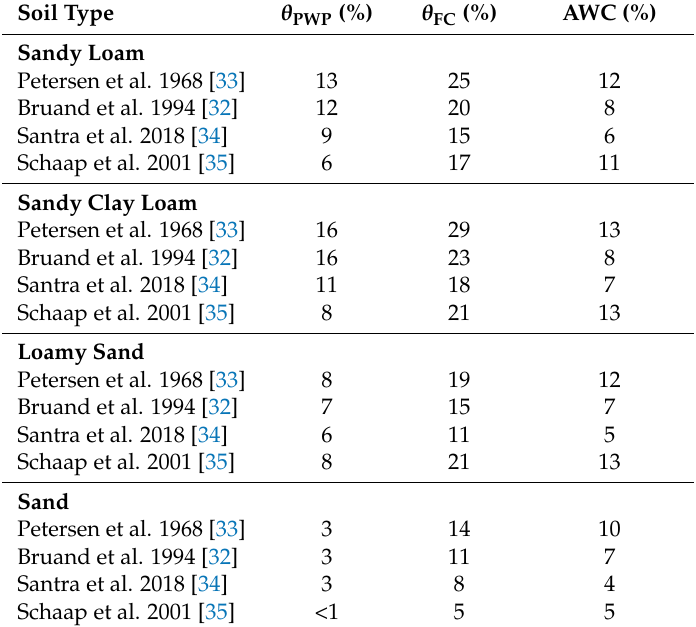
Table A2. Mean θ at permanent wilting point ( θ Pwp ) and field capacity ( θ fc ) for the four soil types identified in both watersheds. Mean θ fc and θ Pwp were calculated with pedotransfer equations based on mean soil particle distribution for each soil type. Available water content (AWC) is θ FC – θ PWP .